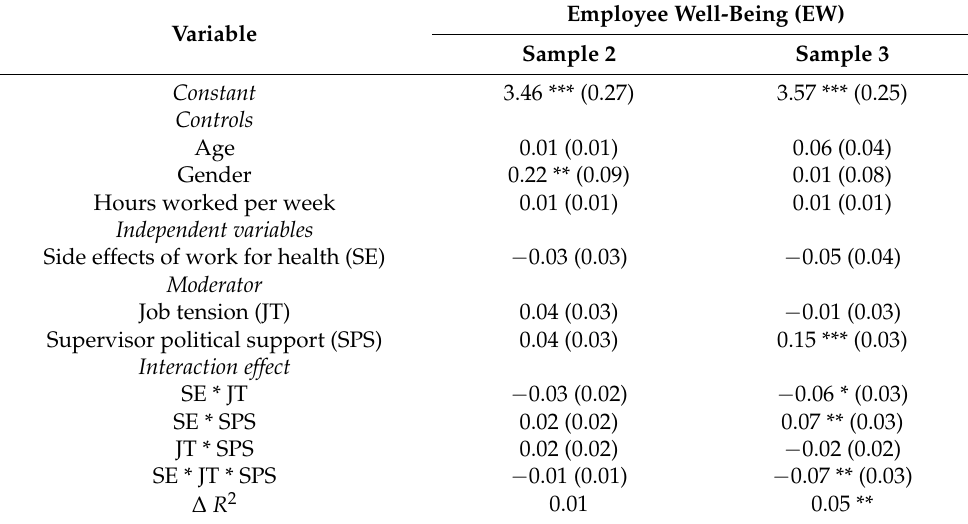
Table 5. Results of three-way interaction of side effects of work on health predicting employee well-being.